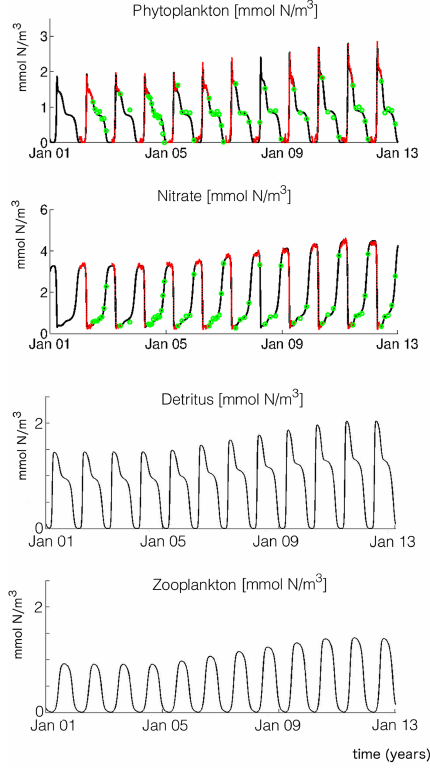
Figure 2. Subsampling of the genuine truth in SPARSE1 and SPARSE2. The black lines in the respective subpanels refer to the genuine truth simulation (based on the parameter set “truth” in Ta- ble 3 under forcing OPTI) of phytoplankton, nitrate, detritus and zooplankton. The green circles show SPARSE1 subsamples dis- torted by “level 1” noise (Sect. 2.5). The combination of red dots (also distorted by “level 1” noise) and green circles refers to data used in